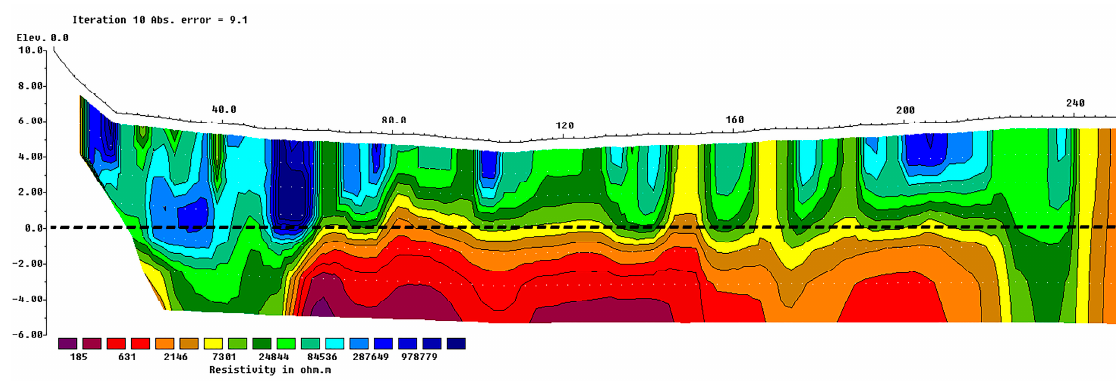
Figure 11. Electrical resistivity tomography carried out in Late November 1996 along the first 250 m of the profile 2 of Figure 8a,b oriented from south (left) to north (right). It is notable as a body of low resistivity (<700 Ω m) occurred in almost all the section under the sea level except for the innermost 60 m and the last 25 m. The low resistivity can be explained as frozen saline permafrost or unfrozen sediment saturated by hypersaline brines. Dashed line indicates the seal level.